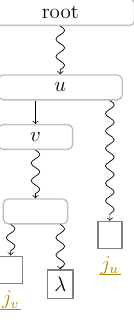
Figure 3. Determining the witness of a factor F whose starting position is the suffix number of the leaf λ . Straight arcs symbolize edges, while curly arcs symbolize paths that can visit multiple nodes (which are not visualized). Given j w is the smallest suffix number among all leaves in the subtree rooted at a node w , and that u is the lowest ancestor of λ with [ j u .. j u + str_depth ( u )